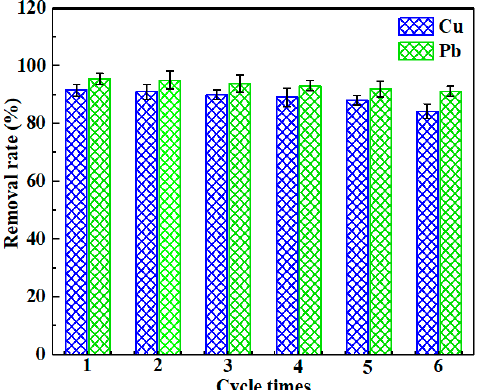
Figure 10. Reusability of CLB for Cu(II) and Pb(II) adsorption (adsorbent dose: 0.25 g;